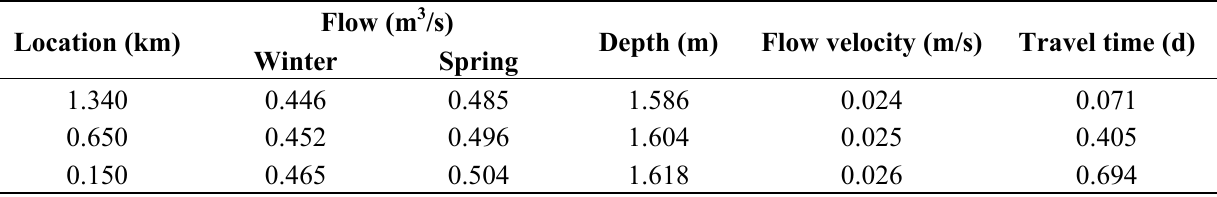
Table 5. Hydraulic characteristics of the three reaches of the Hongqi River. “Location” refers to the distance from the river’s